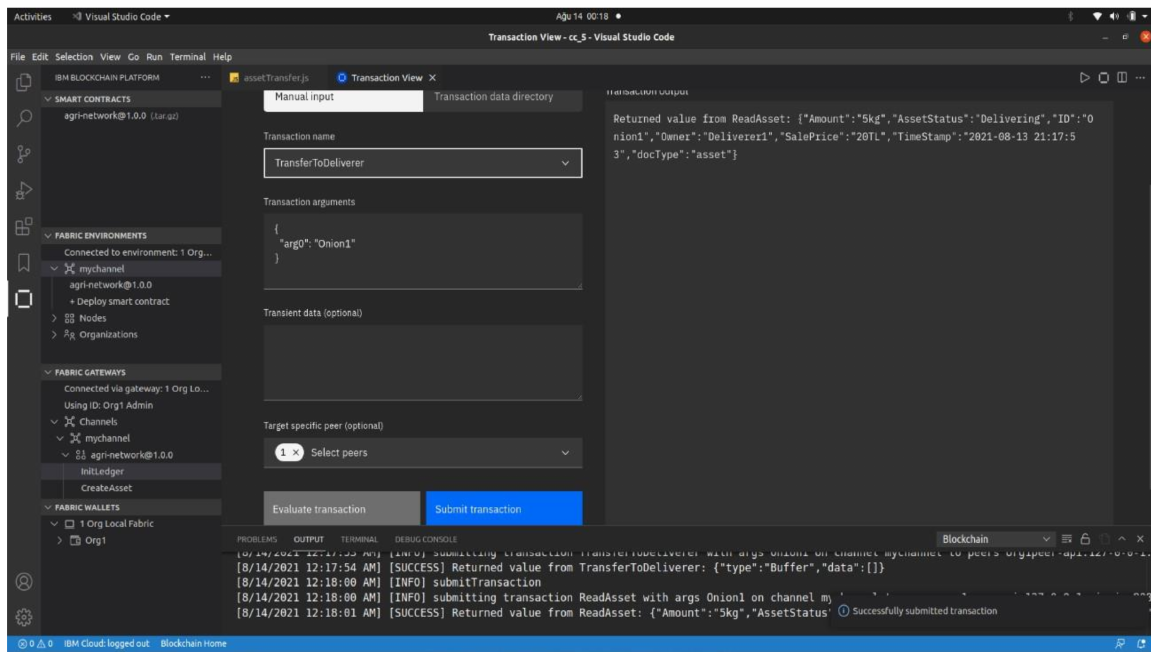
Figure 12. Food tracking system smart contract